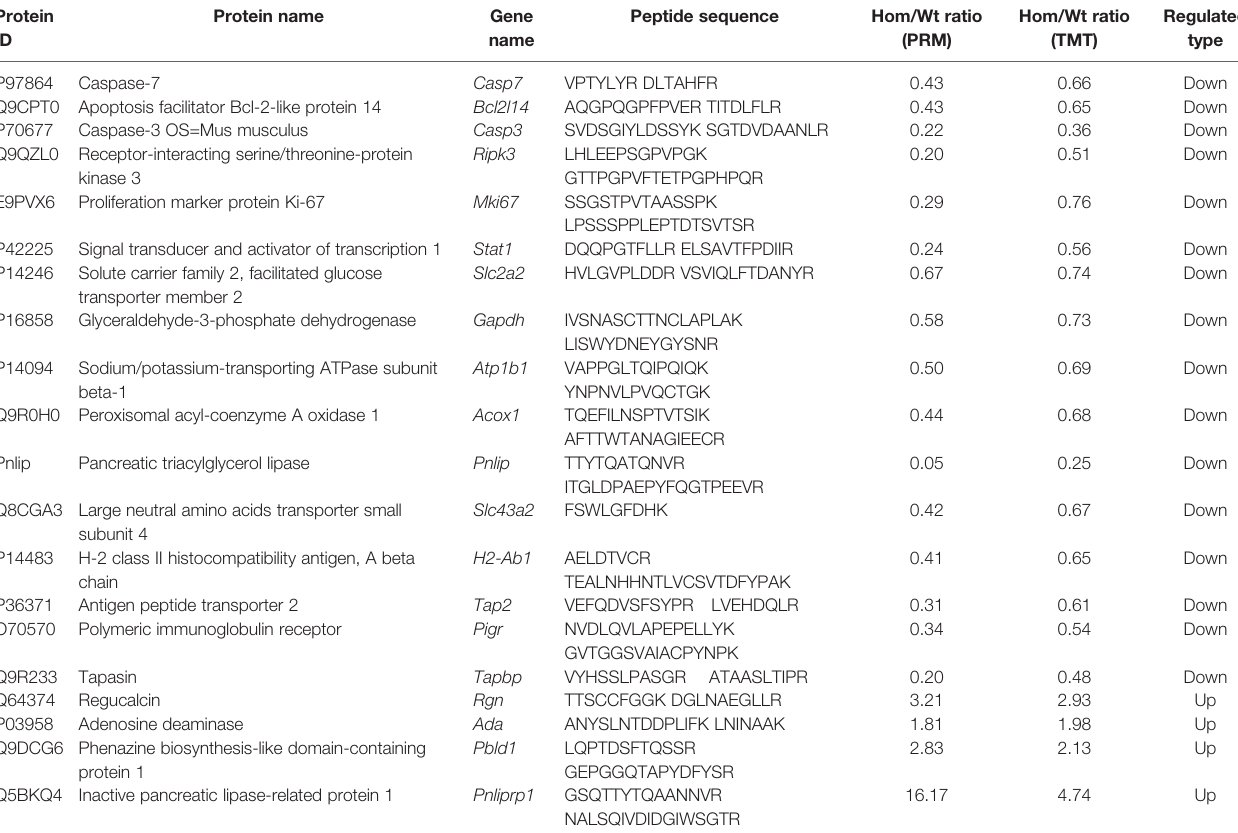
TABLE 1 | Parallel reaction monitoring (PRM) analysis of 20 candidate